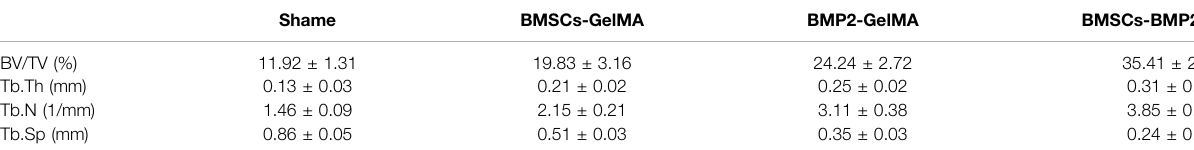
TABLE 2 | Results of rat bone trabeculae parameters at bone defects (Mean ± SEM).